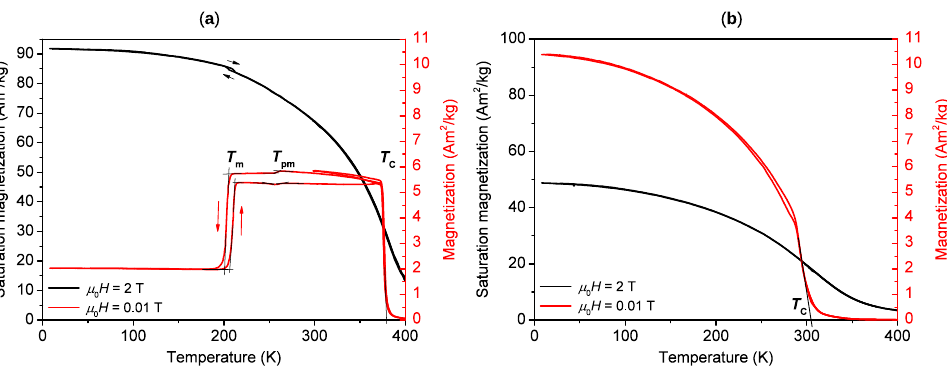
Figure 2. Low-field and saturation magnetization, measured at constant magnetic field µ 0 H of 0.01 T and 2 T, respectively, as a function of temperature: ( a ) (Ni 45.0 Ni 5.4 )Mn 24.6 Ga 25.0 exhibiting Curie temperature T C , premartensitic transition T pm and martensitic transformation T m marked in the figure; ( b ) Ni 49.9 Mn 24.6 (Ga 20.4 Co 5.1 ) exhibiting a martensitic transformation above T C of martensite.